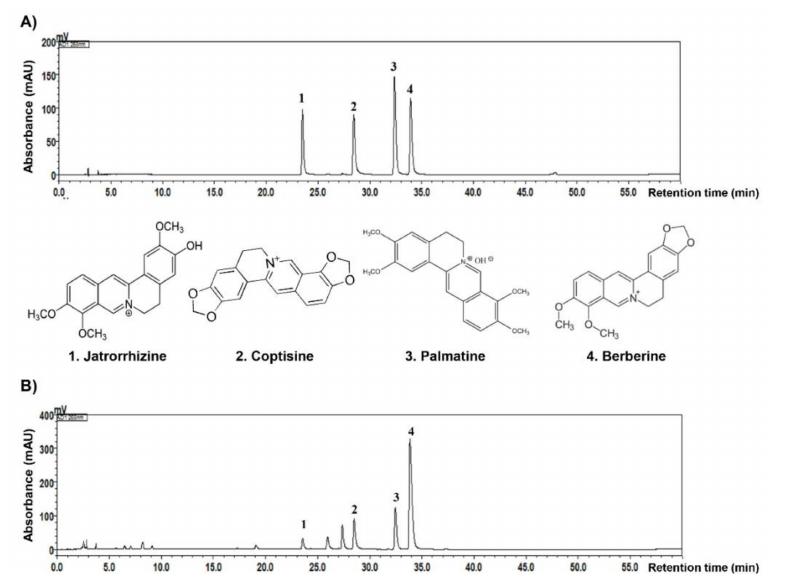
Figure 7. The natural compound fingerprint analysis from high-performance liquid chromatography (HPLC) of CR. ( A ) Four standard compounds of jatrorrhizine, coptisine, palmatine, and berberine were analyzed by HPLC. ( B ) Histogram from the HPLC analysis of